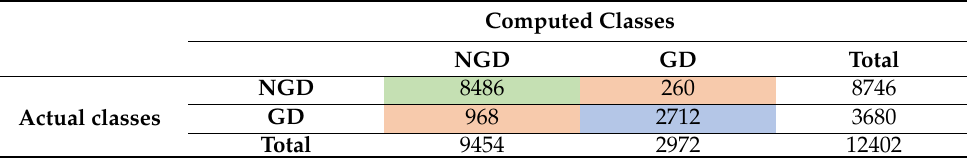
Table 2. Confusion matrix of the guidance display decision algorithm. NGD means no guidance display and GD means guidance display